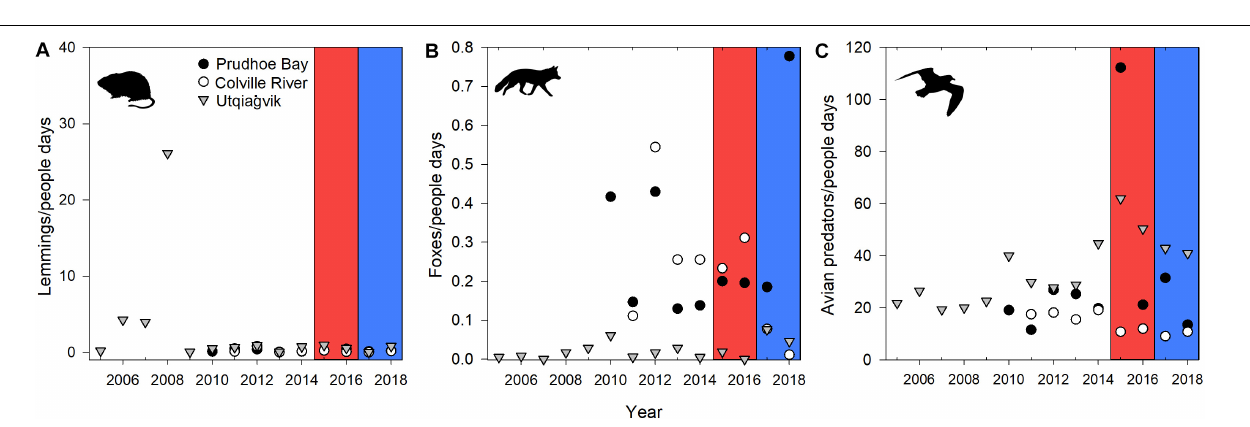
FIGURE 2 | Relative abundance of arvicoline rodents (A) , foxes (B) , and avian predators (C) in June, 2015–2018 in relation to long-term values (i.e., Utqia˙gvik: 2005–2014; Colville River: 2011–2014; Prudhoe Bay: 2010–2014). Fox control was in place at Utqia˙gvik from 2005 to 2016. Early springs (i.e., 2015 and 2016) are illustrated in red while late springs (i.e., 2017 and 2018) are illustrated in